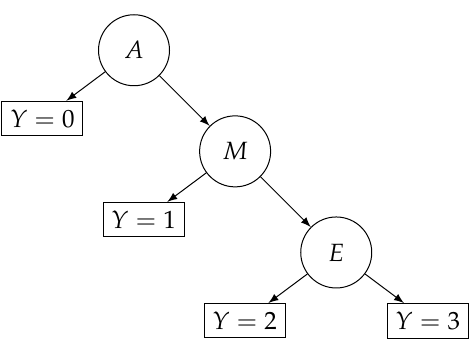
Figure 3. Application : Histograms of the parameters of composite fuzzy indicator depression . (a) : Histogram of the centers c Histogram of right spreads ( r distribution. Note that the intensification parameter shows a concentration closed to one.